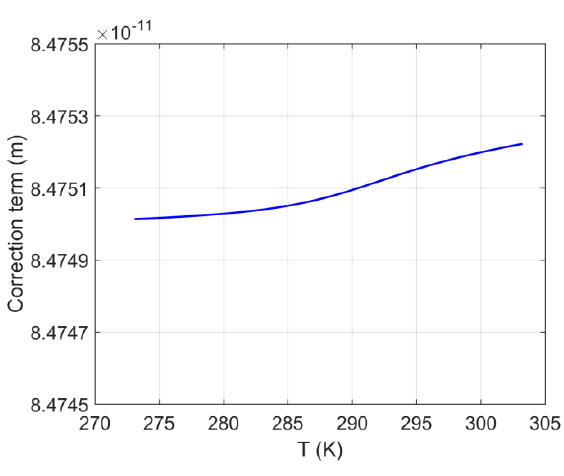
Figure 4. The correction term, r shift , as a function of temperature for a porous system S1. The corresponding pressures are those along the three-phase (H–L w –V) equilibria line for the methane + water binary system.